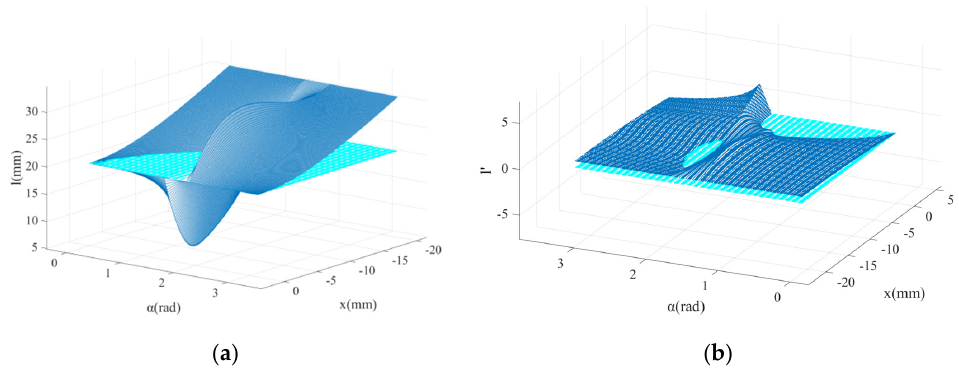
Figure 4. ( a ) Profile of the main cam with different α ; ( b ) derivative diagram of the profile of the main cam with different α